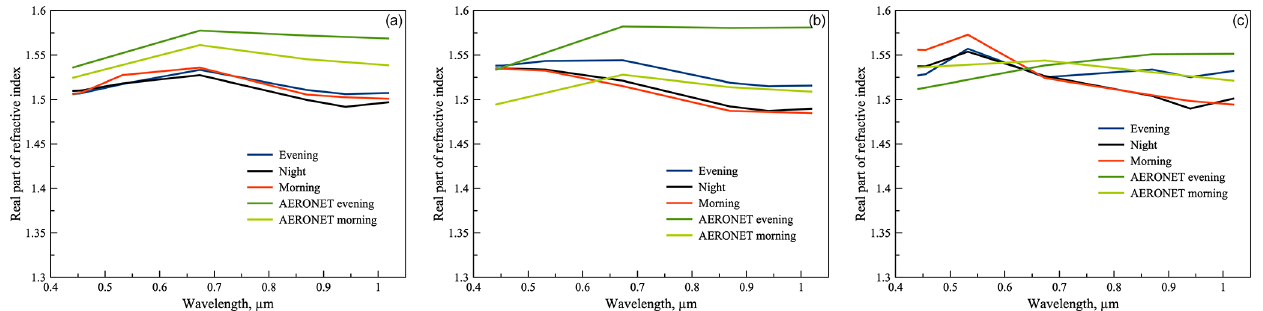
Figure 6. Real parts of aerosol complex refractive indices retrieved during the COBALD radiosonde flight on 5 August 2015 (a) , 11 Au- gust 2015 (b) and 12 August 2016 (c) . Values retrieved before and after the radiosonde flight with the use of combined Sun-photometer and MPL data are shown in blue and red, and those retrieved by AERONET are in dark and light green, respectively.